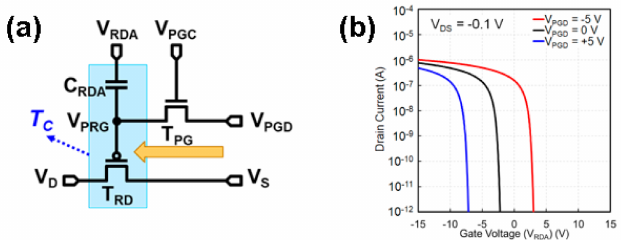
Figure 1. ( a ) Schematic of the memory cell comprising low-temperature polycrystalline silicon and oxide (LTPO) thin-film transistors (TFTs) presented in [24]. ( b ) Simulated transfer characteristics of T C depending on the programmed voltage (V PGD ) [24].